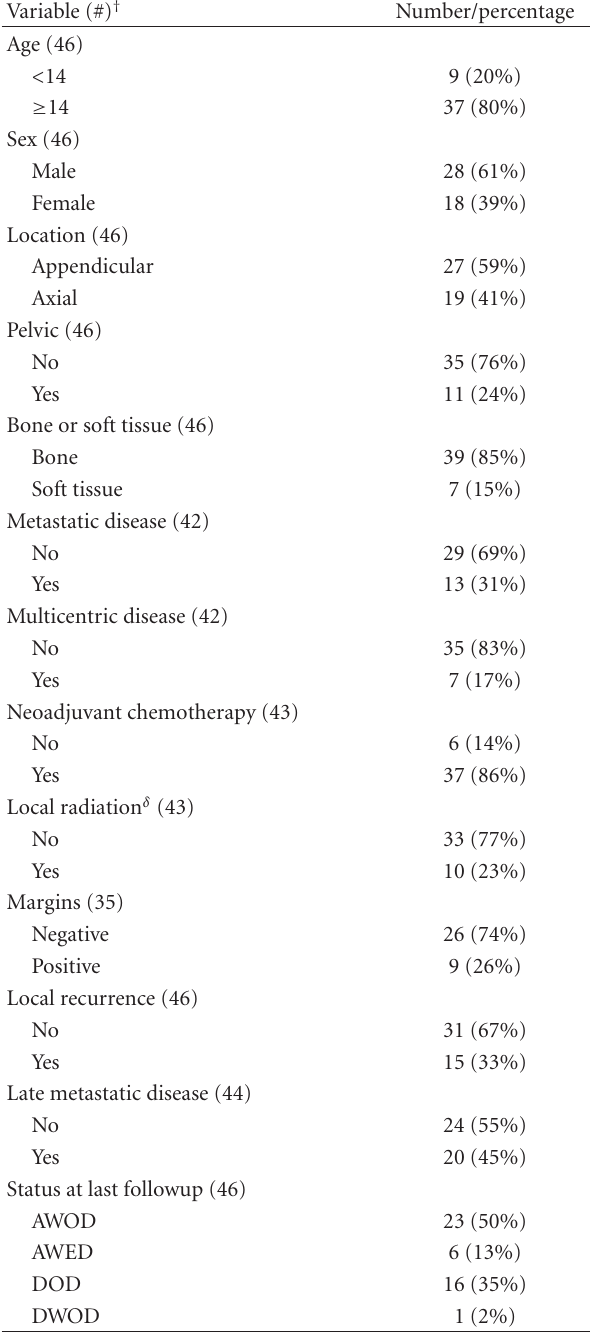
Table 1: Patient